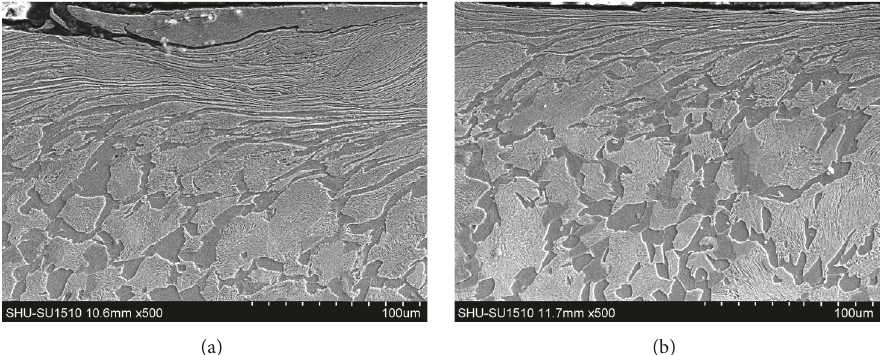
Figure 6: SEM images of the worn subsurface layers of 20CrMnTi pins against the (a) chroming and (b) nonchroming T10 discs.